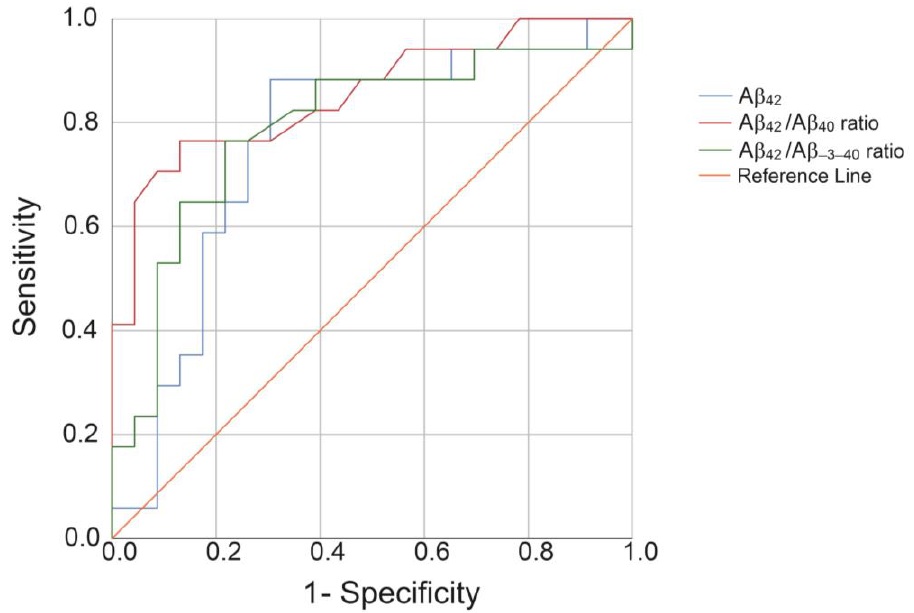
Figure 7. Receiver operating characteristic (ROC) analysis of Aβ 42 , the Aβ 42 /Aβ 40 ratio, and the Aβ 42 /Aβ −3–40 ratio as discriminators of patients with other dementias (OD) and Alzheimer’s type dementia (AD-D). The ROC curves of the indicated biomarker candidates in blood plasma are shown in discriminating the diagnostic groups OD and AD-D. The areas under the curves (AUCs) were 0.760 (Aβ 42 ), 0.790 (Aβ 42 /Aβ −3–40 ratio), and 0.854 (Aβ 42 /Aβ 40 ratio), respectively.